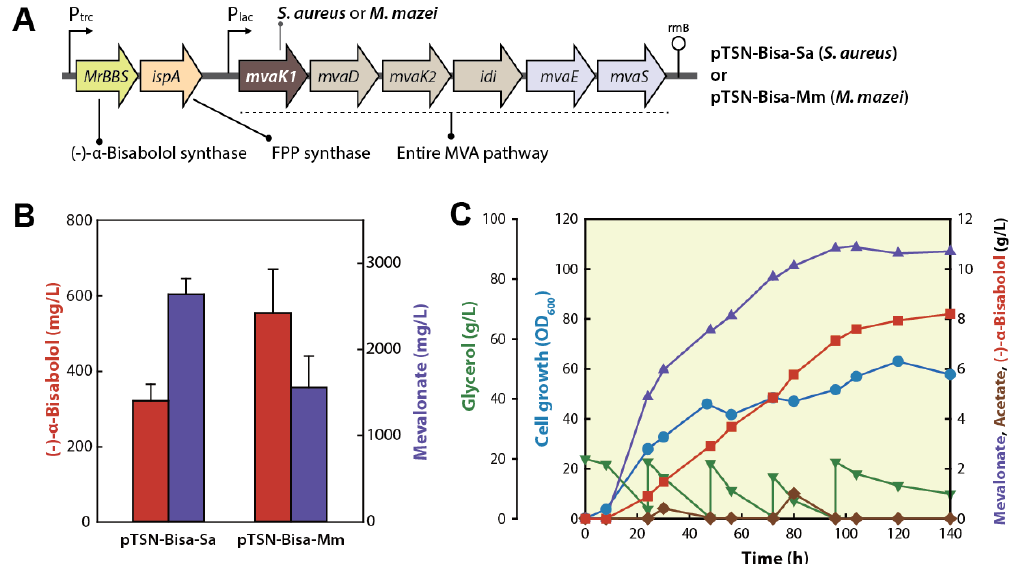
Figure 2. Introduction of MvaK1 from M. mazei for the improvement of (−)-α-bisabolol production. ( A ) Plasmid constructs for expressing the entire MVA pathway, FPP synthase and (−)-α-bisabolol synthase. The plasmid pTSN-Bisa-Sa and pTSN-Bisa-Mm have mvak1 gene of S. aureus and M. mazei , respectively.